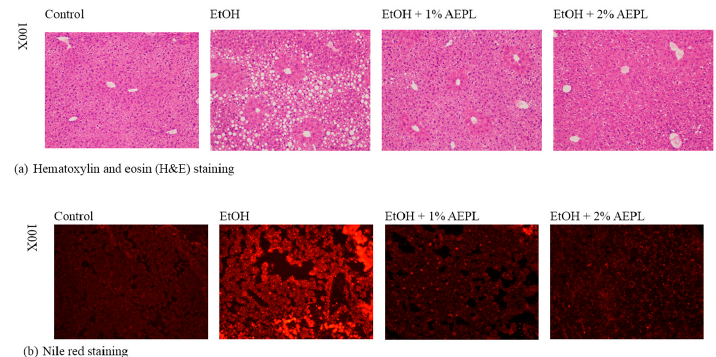
Figure 1. AEPL inhibited chronic alcohol-induced lipid accumulation in mice liver. Morphological